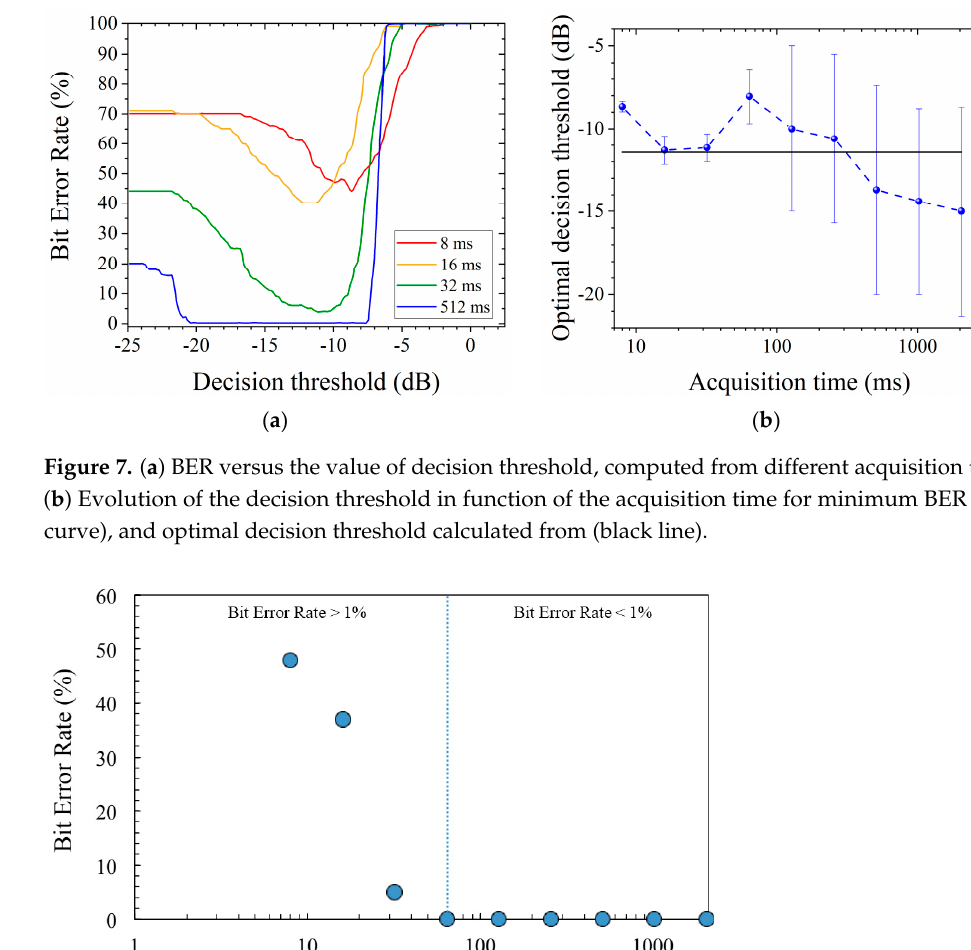
Figure 7. ( a ) BER versus the value of decision threshold, computed from different acquisition times. ( b ) Evolution of the decision threshold in function of the acquisition time for minimum BER (blue curve), and optimal decision threshold calculated from (black line).